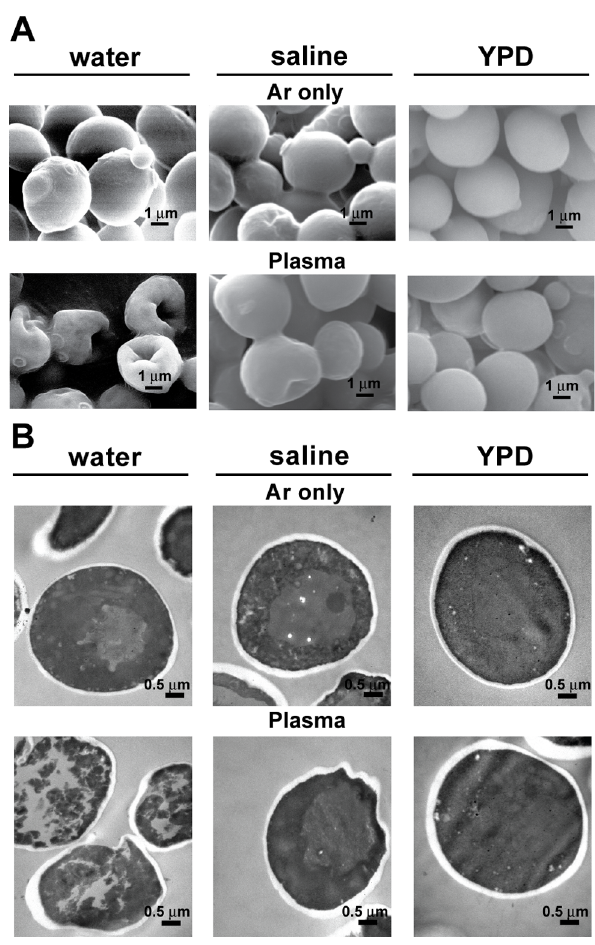
Figure 2. Morphology and internal structure of yeast cells after plasma treatment. ( A ) Cells analyzed by scanning electron micros- copy. ( B ) Cells analyzed by transmission electron microscopy. Yeast cells in water, saline, and YPD were exposed to Ar gas and plasma for 3 min and used for the microscopic analysis.